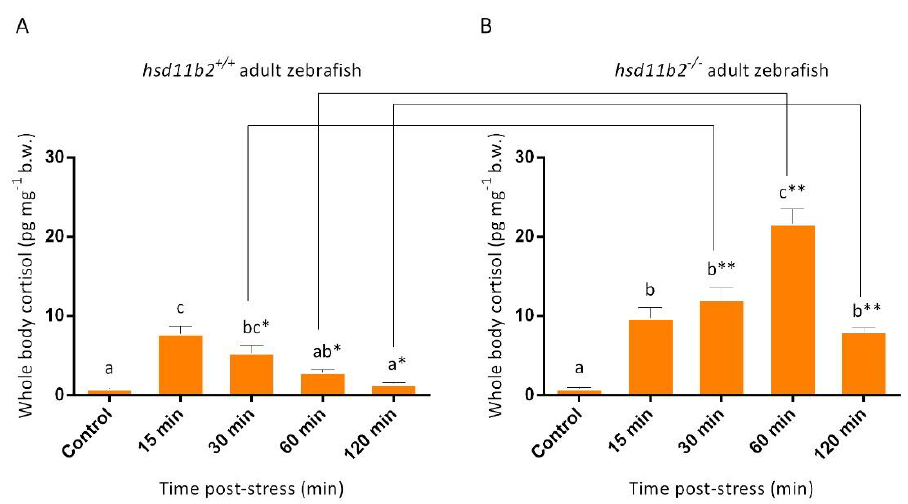
Figure 6. Effect of acute stress application on whole-body cortisol concentrations of one-year-old adult zebrafish, as depicted by bar graphs. Measurements of 10 hsd11b2 +/+ ( A ) WT and 10 hsd11b2 − / − ( B ) mutant zebrafish prior to (control) at 15 min, 30 min, 60 min and 120 min after the stress application. Values are means ± SEM. Means with different letters differ significantly from one another ( p < 0.001). Asterisks show statistically significant differences between the two groups ( p < 0.001). Holm-Sidak comparison test was applied to identify groups that were significantly different. * p < 0.05, ** p < 0.01.